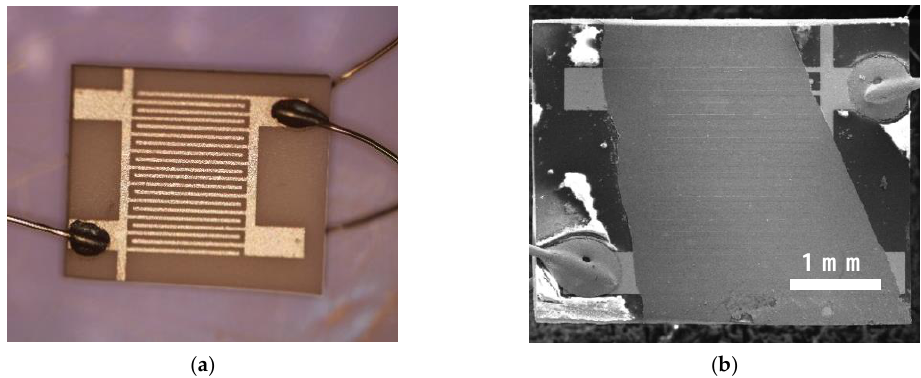
Figure 1. Optical microscope image of the alumina-sensing platform with Pt electrodes ( a ) and SEM image of the ZnO NRs prepared on it ( b ).